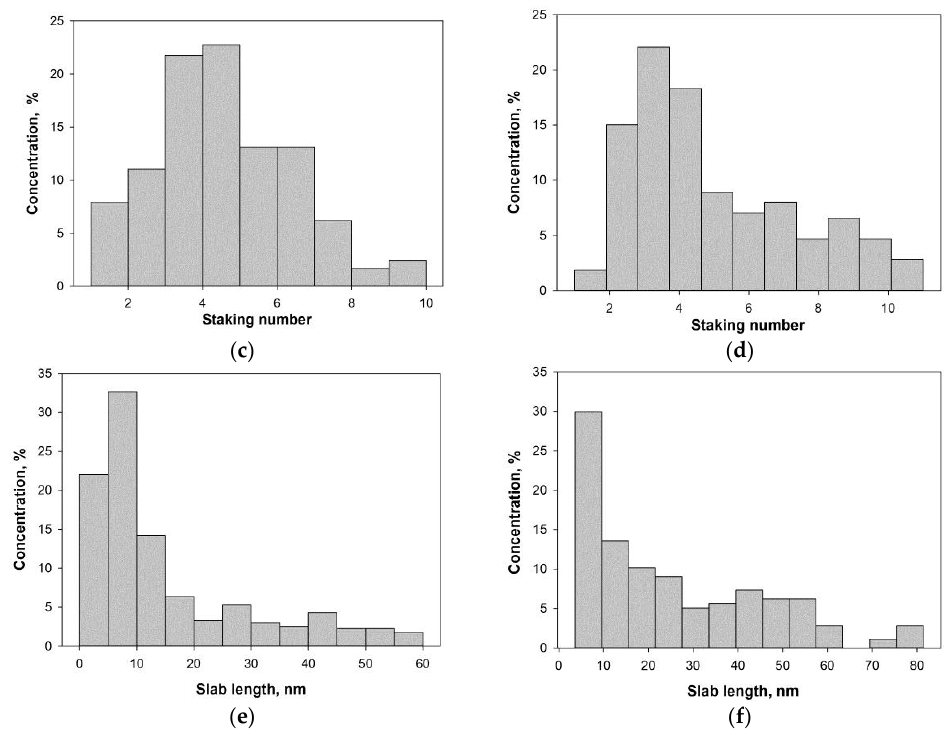
Figure 3. Representative micrographs of the catalysts: ( a ) PAF-NiWS; ( b ) PAF-NiMoS; distribution of particles with according to their length and stacking number of slabs: ( c , e ) for PAF-NiWS; ( d , f ) for PAF-NiMoS.